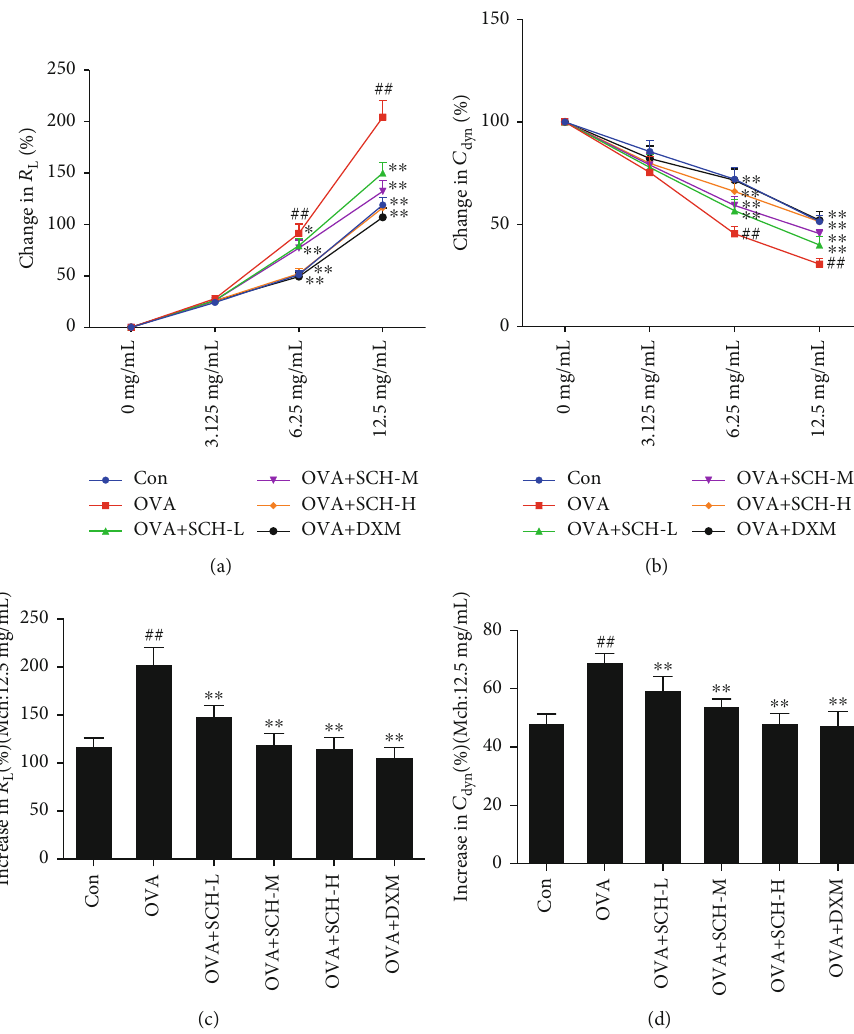
C R C L (%) and dyn (%) were evaluated. (c, d) L (%) and dyn (%) were again assessed separately after the